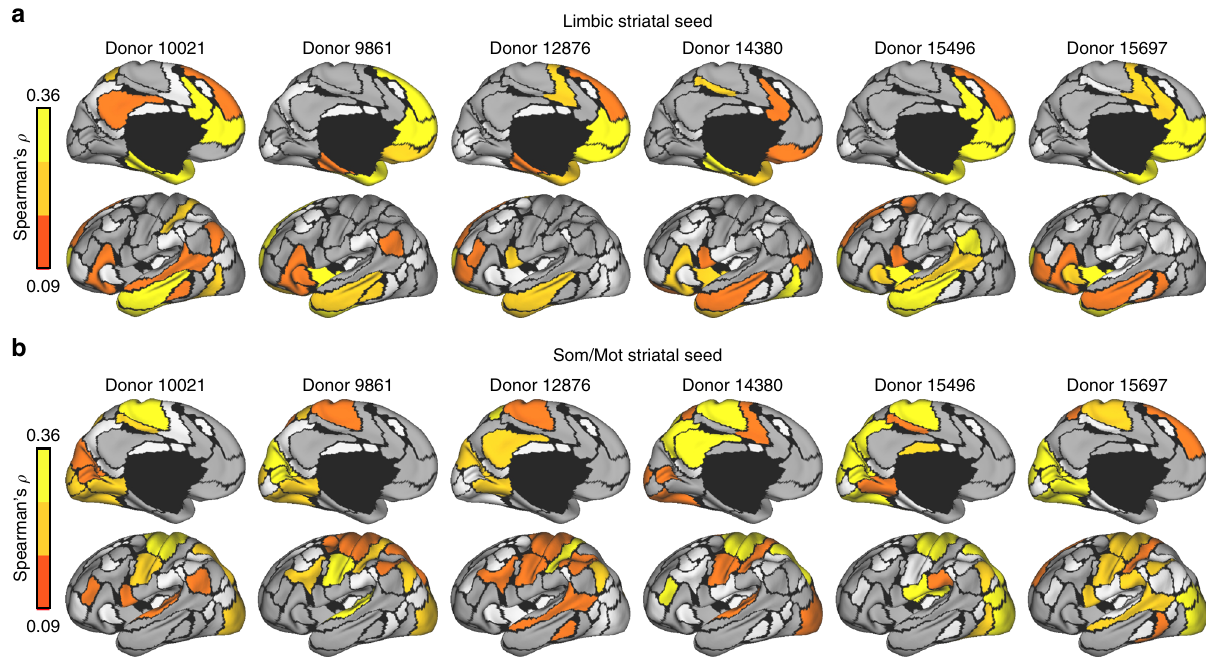
Fig. 5 Cortico-striatal genetic correlations are consistent within individual donors. Genes exhibiting differential expression across cortical networks in all six AHBA donors were examined (count = 4912). For each donor, gene expression in the a limbic and b somato/motor striatal regions were correlated to each cortical region for which data was available. White denotes regions for which no data were available. Grey denotes Spearman ’ s correlations <